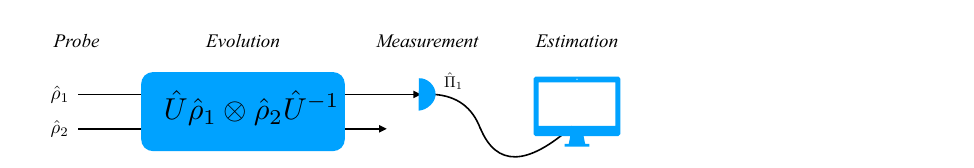
Figure 3. Scheme for the indirect estimation of the temperatures of two interacting trapped ions. After some interaction time between the two ions, a energy measurement corresponding to the number of phonons is performed on the 1-ion, followed by post-processing for the estimation of parameters T 1 and T 2